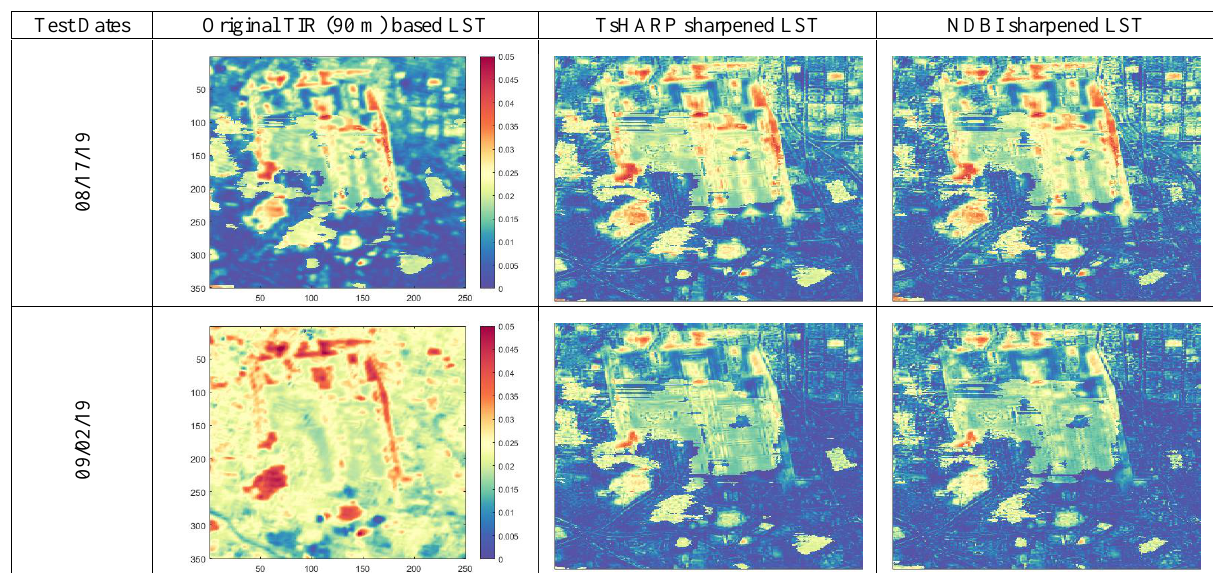
Figure 9. Visual representation of CC results found in Table 3